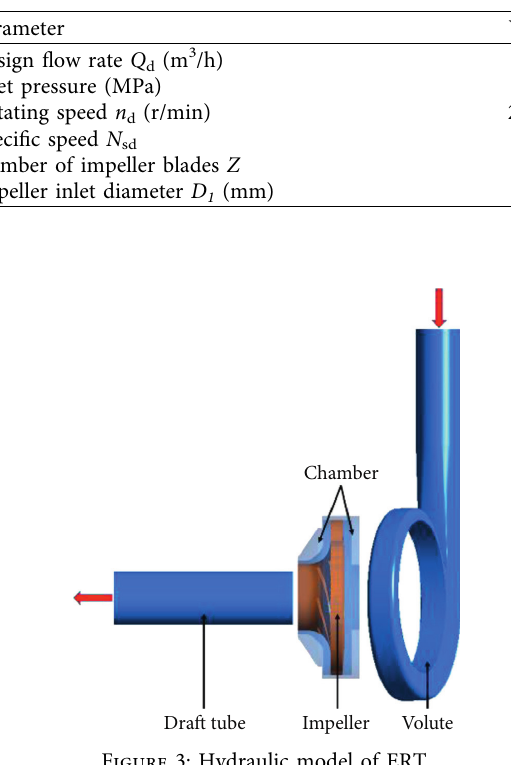
Table 1: Main design parameters of ERT.